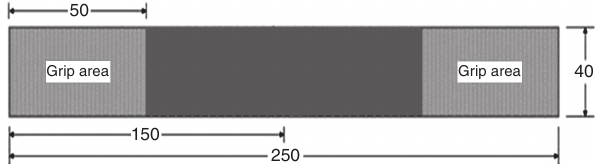
Figure 4 Unnotched composites